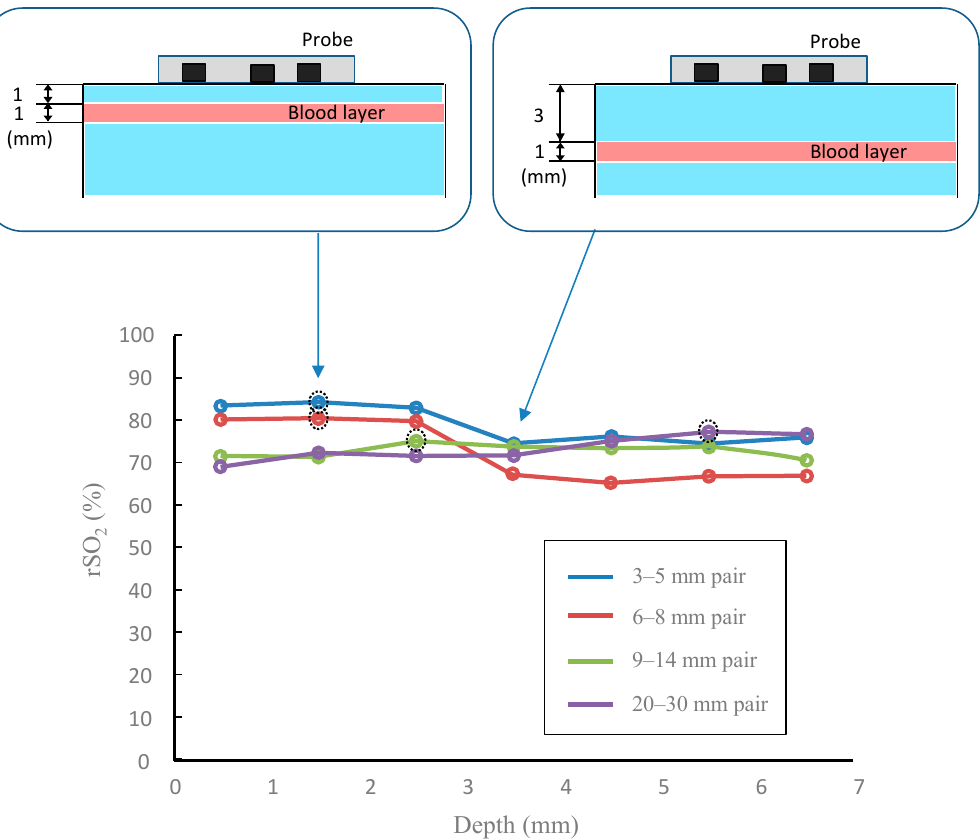
Figure 6. The results of the phantom experiments. Changes in regional oxygen saturation (rSO 2 ) with four probes when blood layer depth changes. The dashed circles represent the peak values of each curve. For example, when the blood layer was at a depth of 1–2 mm, the data were plotted at a depth of 1.5 mm.